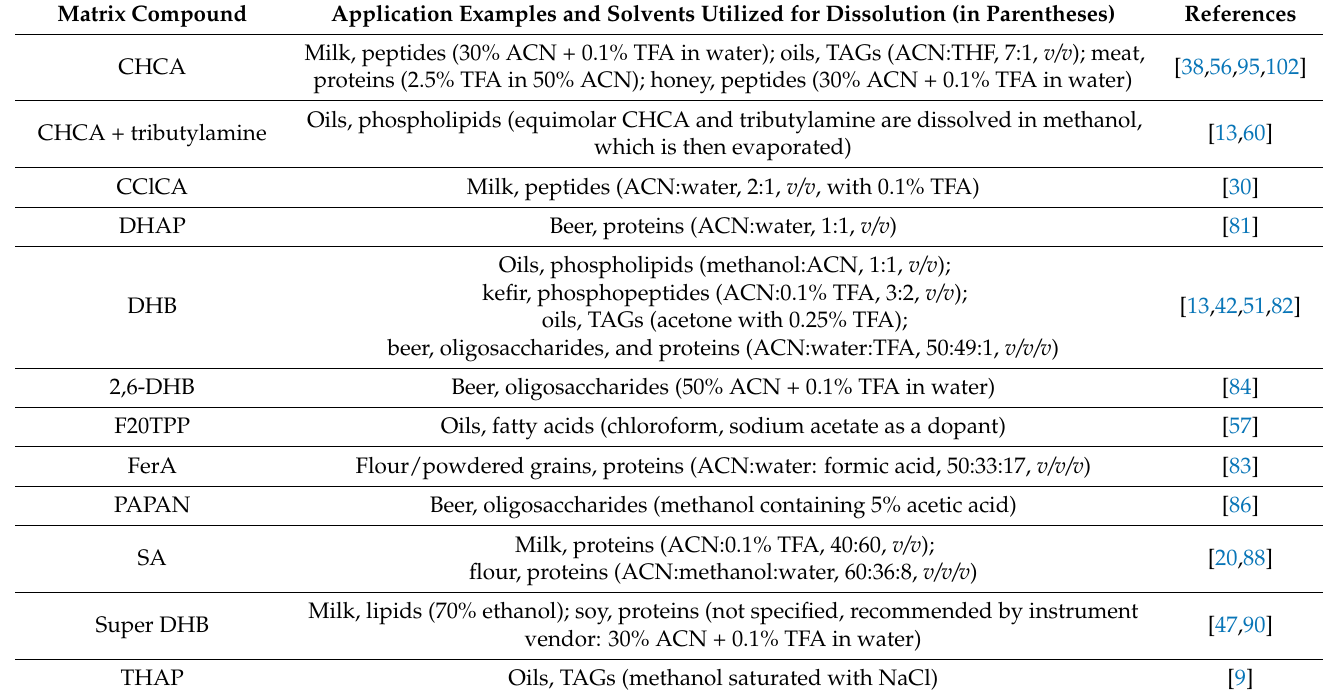
Table 1. An overview of the MALDI matrices that have been used for food and beverage analyses. Matrix Compound Application Examples and Solvents Utilized for Dissolution (in